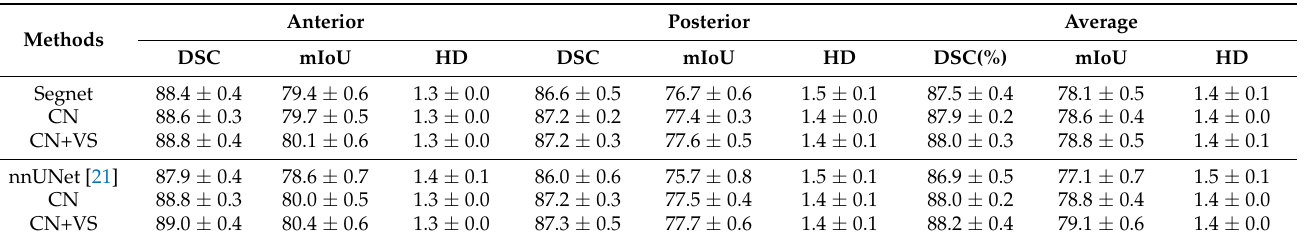
Table 5. Ablation study results of our proposed framework for the hippocampus dataset in terms of DSC (%), mIoU (%), and HD (mm).